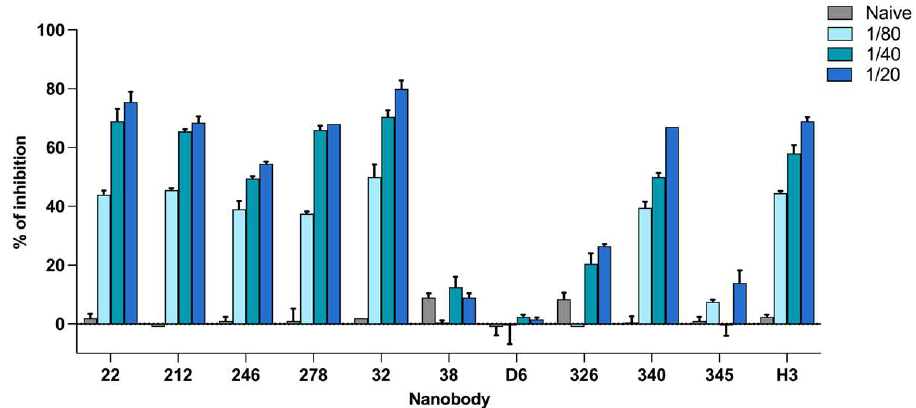
Figure 2. Inhibition achieved over different nanobodies by anti-Zika standard serum. Nanobodies were challenged with three dilutions of WHO IS 16_352 standard and with a pool of naïve sera (1/20 diluted). The percentage of binding inhibition for each Nb is shown. Measurements are the average of duplicates .